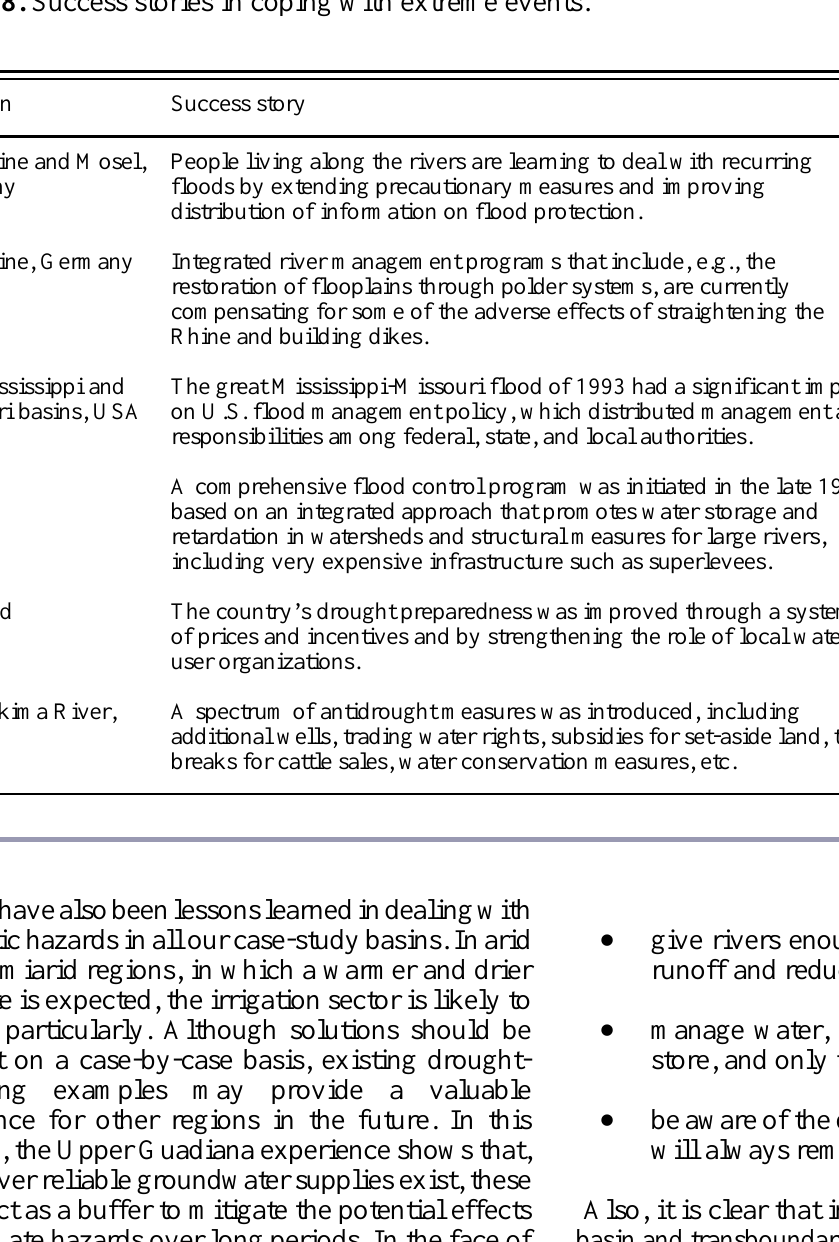
Table 8. Success stories in coping with extreme